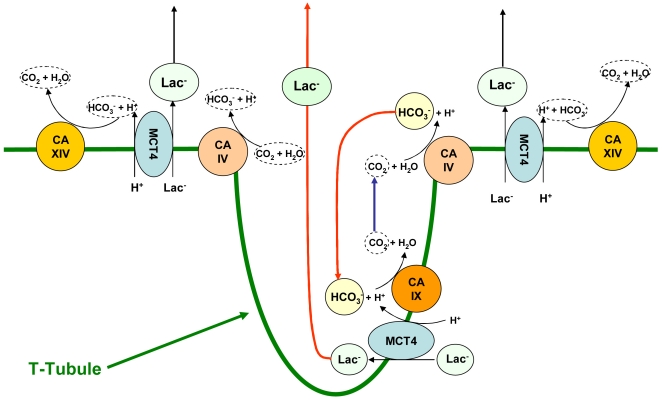
Schematic representation of the cooperation of the MCT4 and the three membrane-bound CAs in lactic acid transport across the sarcolemma.About half of lactic acid transport (in this scheme efflux) occurs via the surface membrane, supported by the buffering action of CA XIV and CA IV. The other half occurs via the T tubular membrane and is supported by the buffering action of CA IX. CA IX and half of the total sarcolemmal MCT4 are colocalized in the T tubule. The removal of lactic acid from the T tubules occurs by outward diffusion of lactate, while the H+ are transported out by an inward diffusion of HCO3
− in combination with an outward diffusion of CO2, a CO2- HCO3
− shuttle. This removal mechanism operates effectively in spite of the long diffusion distance from the T tubule interior to the extracellular space due to very large concentration gradients of lactate and HCO3
− that can build up along the T tubule. These gradients and the mobility of protons are much smaller in the sarcoplasm of the fiber.